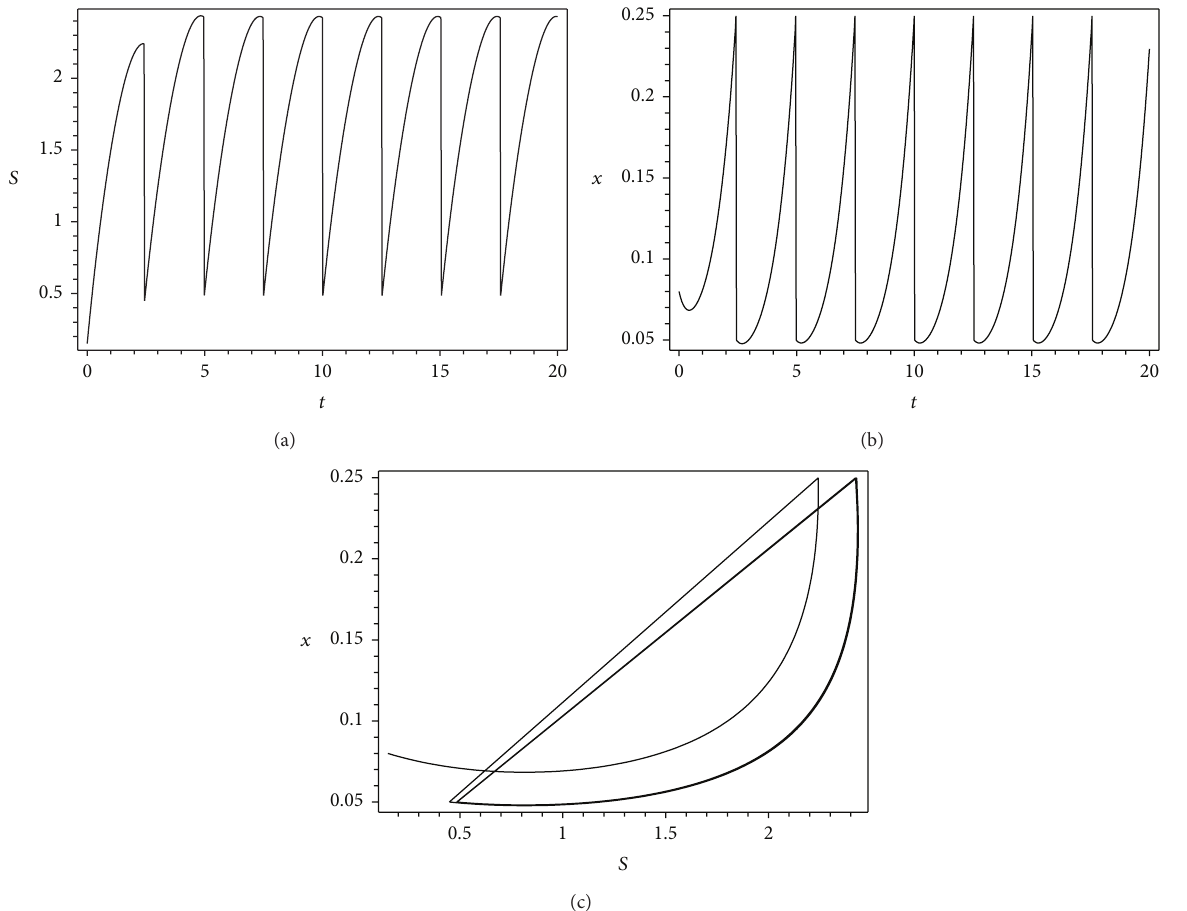
Figure 6: Time series and phase portrait of system (2) with 𝛿 1 = 0.6 , 𝐾 𝑠 = 2 , 𝑆 𝑖 = 4.7 , 𝐷 = 0.4 , 𝜇 = 3.8 , 𝐾 𝑑 = 0.7 , 𝑏 = 0.8 , 𝑆 0 = 0.15 , 𝑥 0 = 0.08 , ℎ = 0.25 < 𝑆 ∗ .